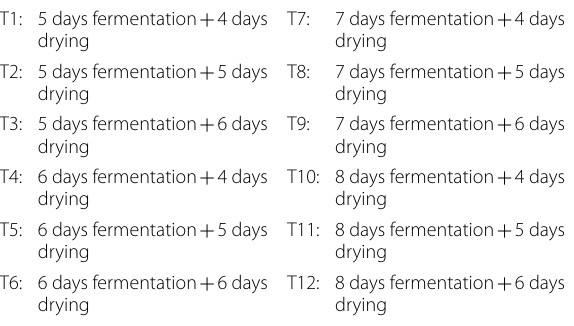
May–June and September–October. The mean annual